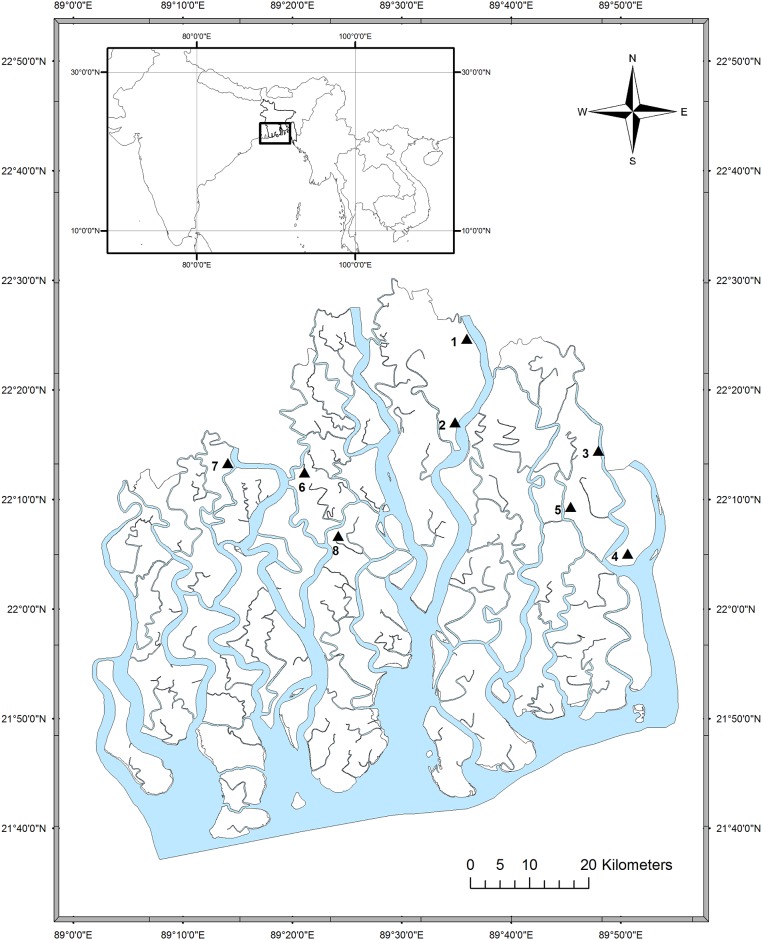
Map showing the sampling locations (triangles) in the Sundarbans.Locations 1 to 5 represent low salinity (eastern), and 6 to 8 are high salinity (western) zone. The map was created using the ArcGIS software (version 10.3, URL: http://www.esri.com/software/arcgis/new).